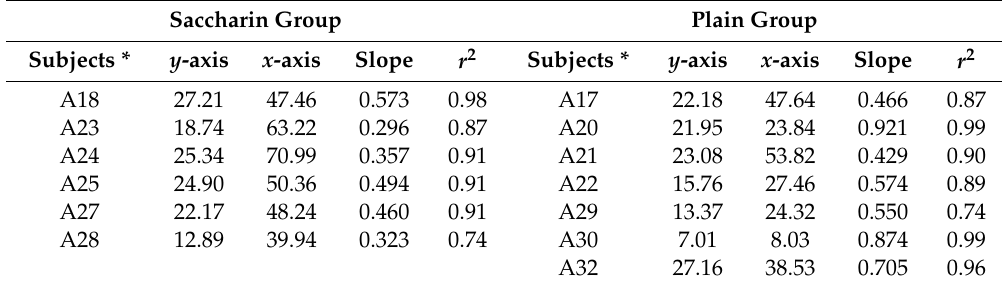
Table 1. Individual subject parameters derived from Equation (1). Saccharin Group Plain